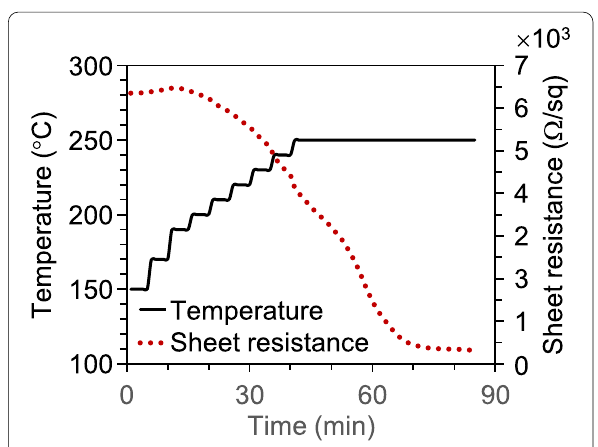
Fig. 4 Variation in the sheet resistance with heating temperature and